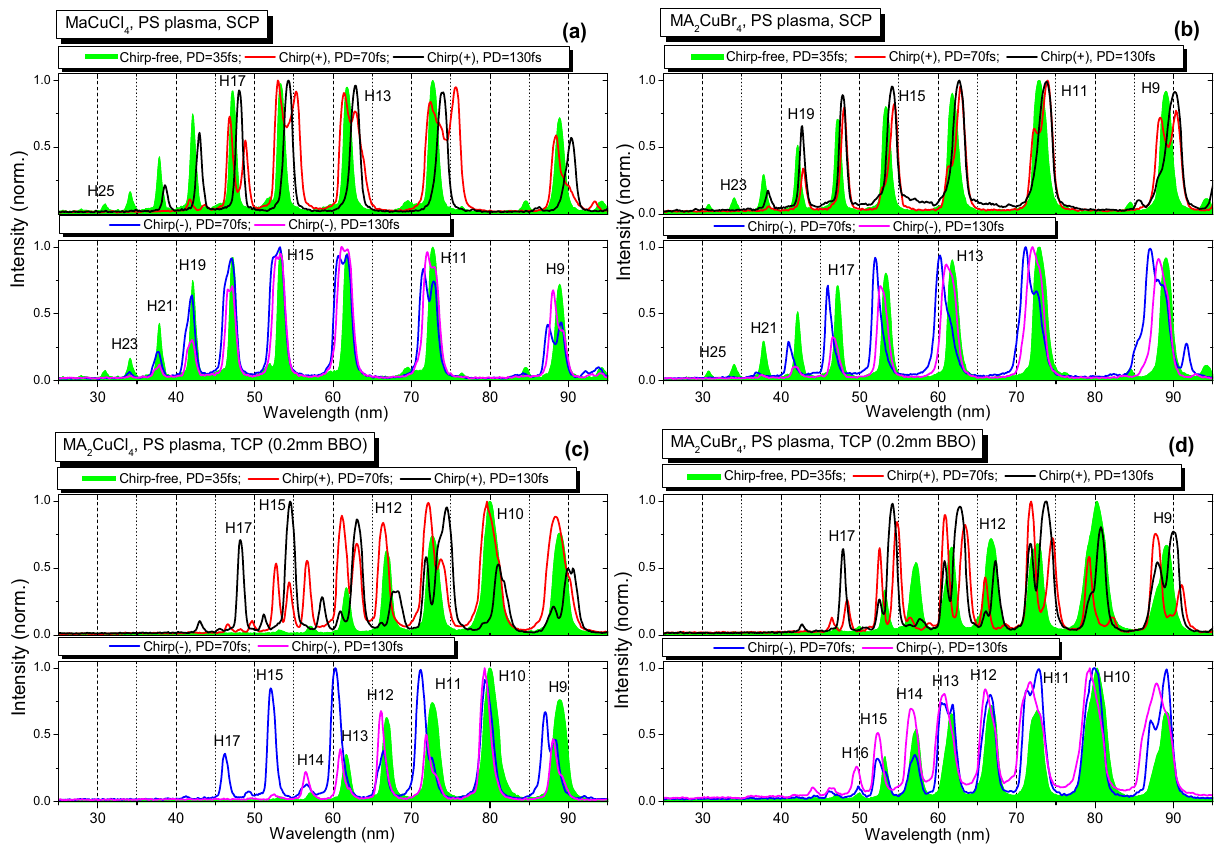
Figure 3. HHG spectra from two plasmas produced using the PS HP. Panels ( a ) and ( b ) correspond to SCP HHG in MA 2 CuCl 4 LIP and MA 2 CuBr 4 LIP respectively. TCP data are presented on the panels ( c ) HHG in MA 2 CuCl 4 LIP and ( d ) HHG in MA 2 CuBr 4 LIP. The harmonic spectra depending on the pulse duration and the sign of chirp are shown. Green filled profiles of harmonics correspond to the chirp-free 35 fs PP (Chirp- free, PD = 35 fs), red curves correspond to the positively chirped 70 fs PP (Chirp( +), PD = 70 fs), blue curves correspond to the negatively chirped 70 fs PP (Chirp(-), PD = 70 fs), black curves correspond to the positively chirped 130 fs PP (Chirp( +), PD = 130 fs), and purple curves correspond to the negatively chirped 130 fs PP (Chirp(-), PD = 130 fs).